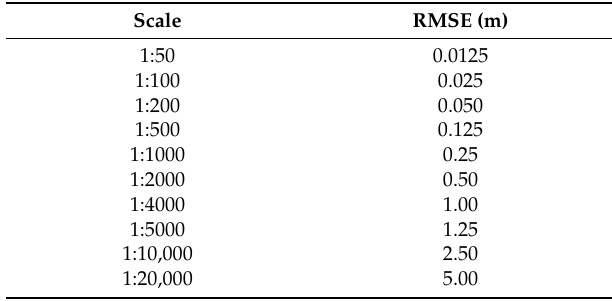
Table 4. Maximum expected error according to scale variation FGDC [46].